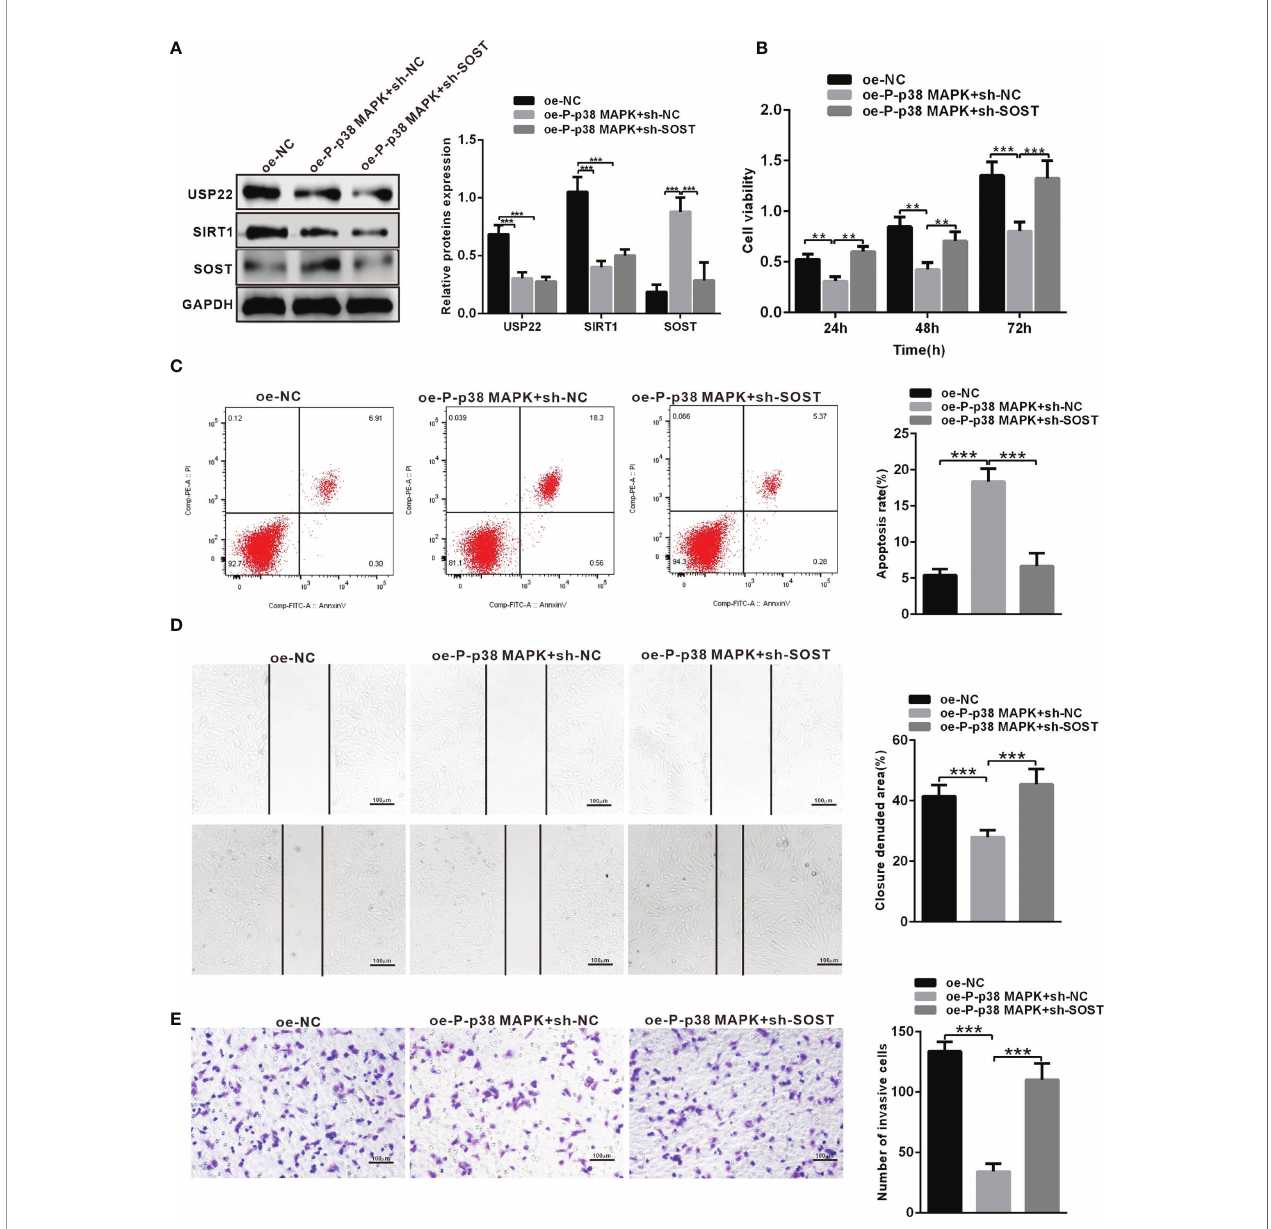
FIGURE 6 | P-p38 MAPK inhibits the development of RB by USP22/SIRT1/SOST axis. (A) The expression of USP22, SIRT1 and SOST in the transfected cells was examined by western blot analysis. (B) Cell activity was detected using CCK-8. (C) Cell apoptosis was tested using fl ow cytometry. (D) Cell migration was detected using scratch test. (E) Cell invasion was measured using Transwell assay. ** p < 0.01, *** p < 0.001. The measurement data was expressed by mean ± standard deviation. The two groups of data conforming to the normal distribution were compared using unpaired t